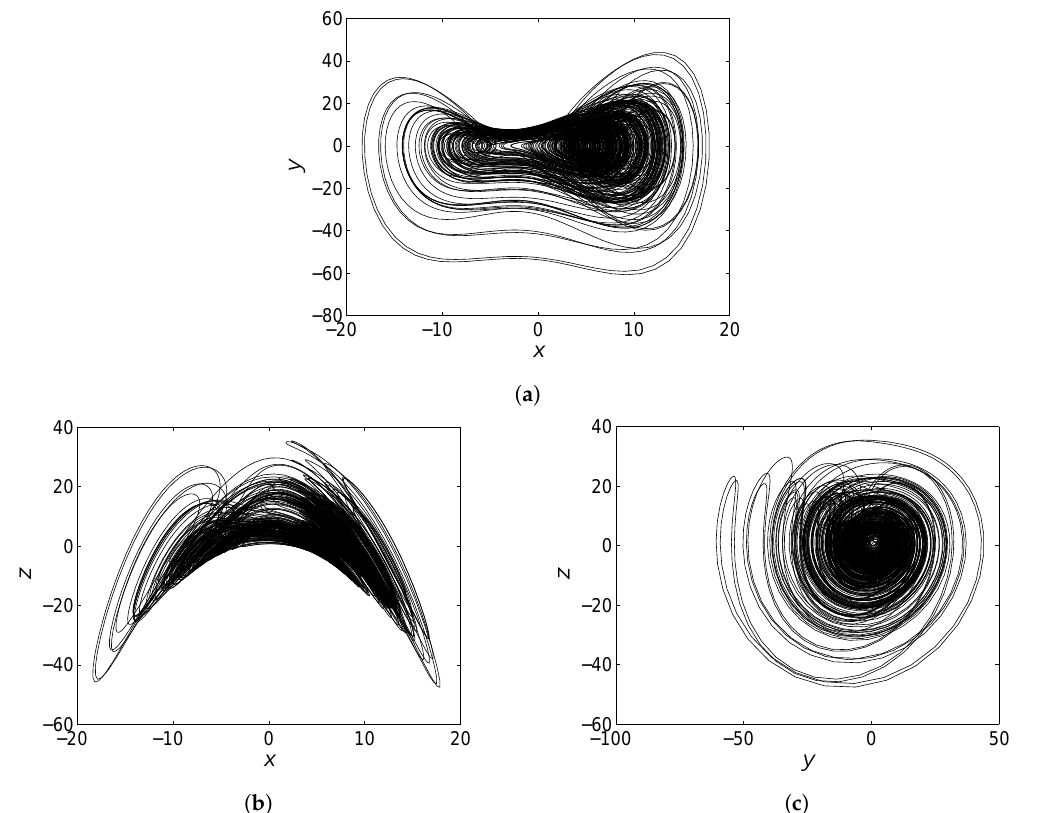
Figure 1. Different attractors without equilibrium in ( a ) x − y plane, ( b ) x − z plane, and ( c ) y − z plane. The parameter set is a = 2, b = 2.5, c = 0.2, d = 0.3 and initial conditions are ( x ( 0 ) , y ( 0 ) , z ( 0 )) = ( 1,1,1 ) .